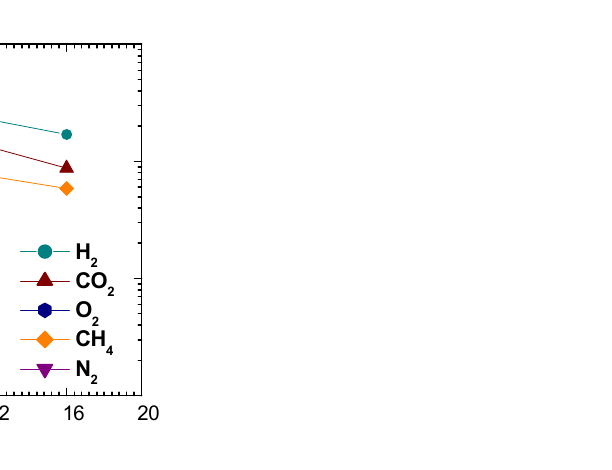
Figure 11. Activation energy of diffusion of various gases in PSf/ZIF-8 mixed matrix membranes as a function of ZIF-8 wt%.